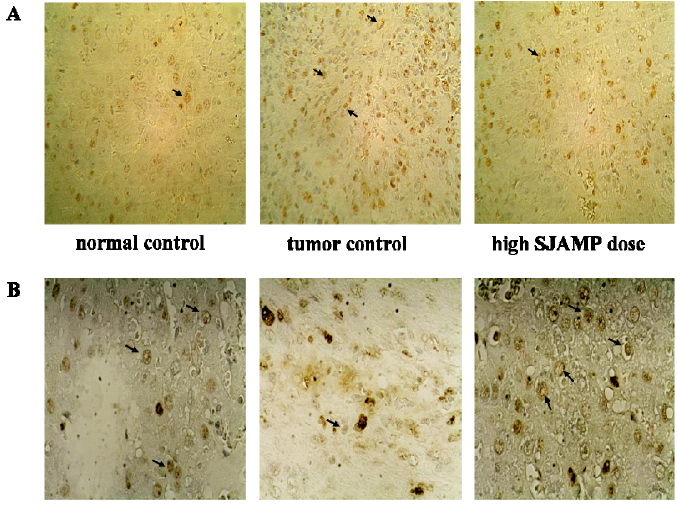
Figure 3. Representative photographs for immunohistochemical staining studies of PCNA and p21. ( A ) PCNA-stained cells (indicated with arrows) in normal control group, tumor control group and high-SJAMP-dose group (magnification factor × 200); ( B ) p21-stained cells (indicated with arrows) in normal control group, tumor control group and high-SJAMP-dose group (magnification factor ×